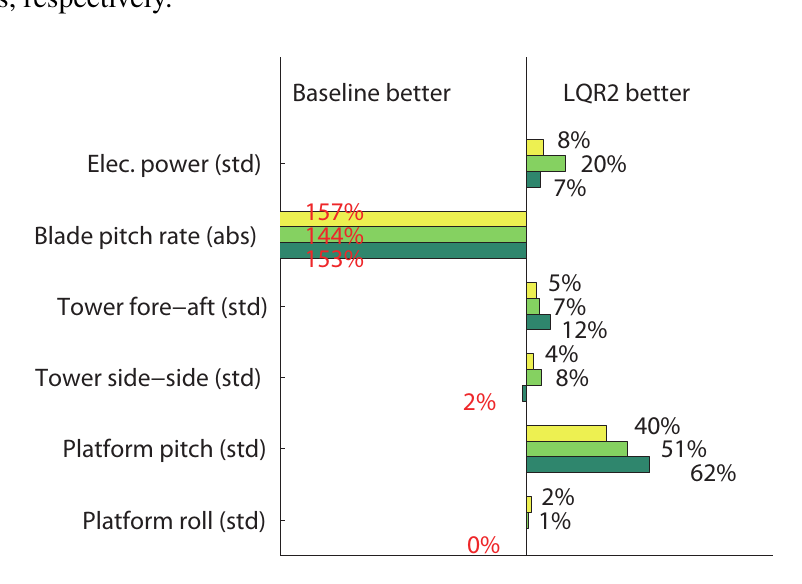
Figure 12. Aligned wind-wave forces: statistical analysis of relative controller performance, where yellow, light green and dark green represent peak wave periods of 2, 5 and 10 s, respectively.